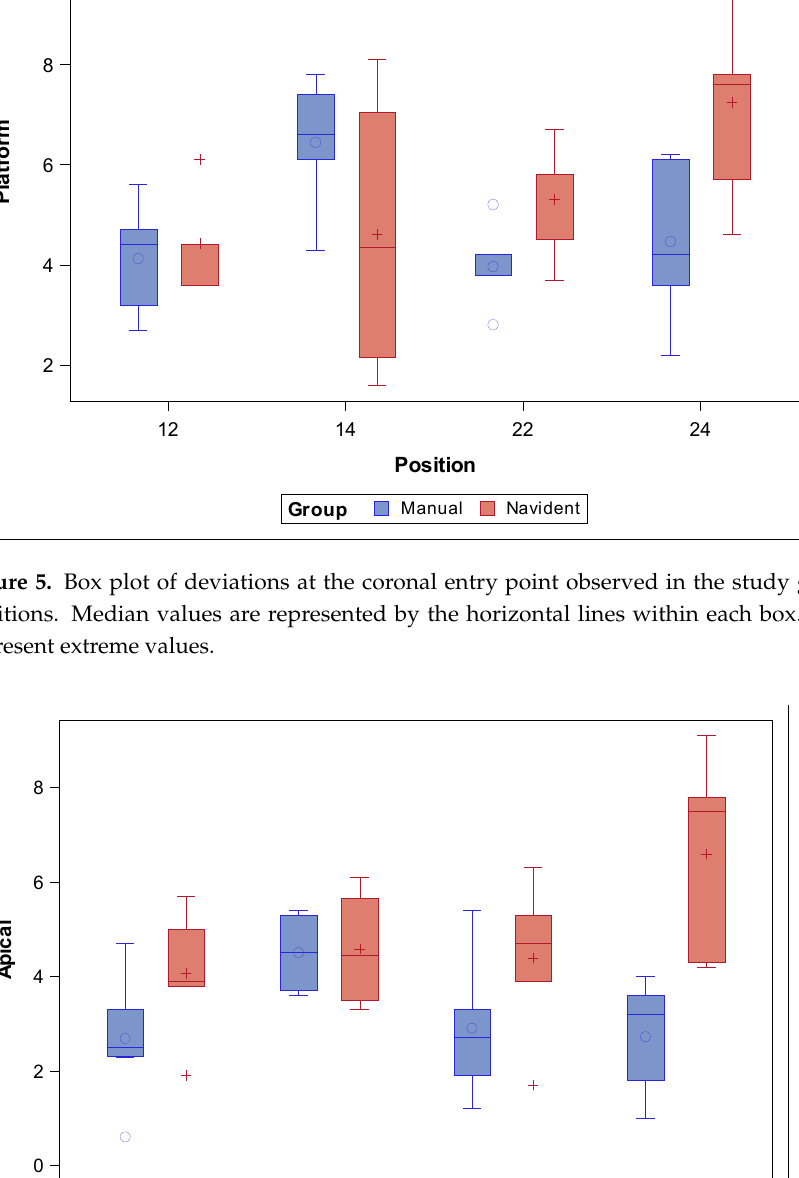
Figure 6. Box plot of apical end-point deviations recorded in the study groups and ZI positions. Median values are represented by the horizontal lines within each box. The symbols represent extreme values.